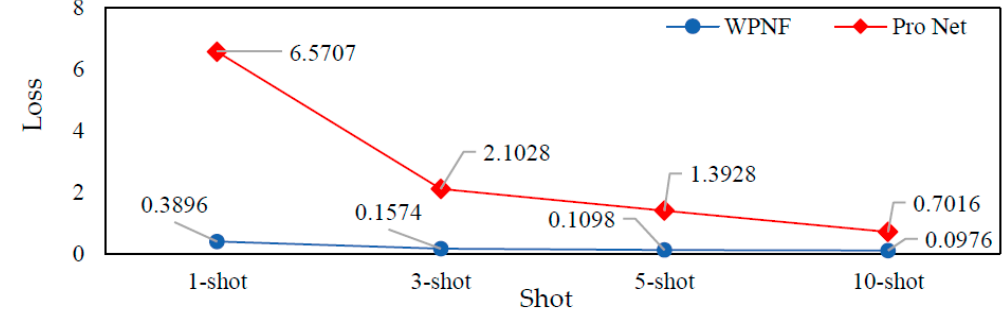
Figure 10. Comparison results of loss of the wavelet-prototypical network based on fusion of time and frequency domain (WPNF) and Pro Net.